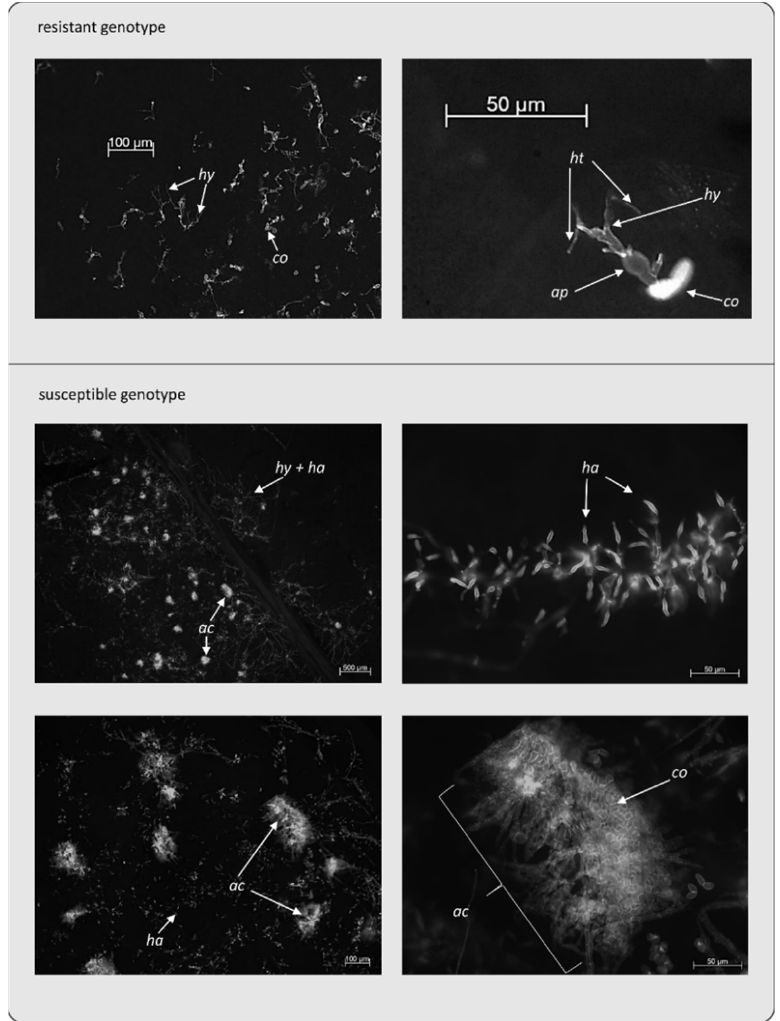
Figure 4. Microscopic analysis of resistant and susceptible 97/7 genotypes. Example of D. rosae growth on leaves of the resistant r_244 and susceptible s_104 genotypes at 7 dpi. The arrows point to co: conidium, ap: appressorium, hy: hyphae, ha: haustorium, ht: haustorial tube, ac: acervulus. Samples were stained with Alexa Fluor 488-conjugated wheat germ agglutinin (WGA).